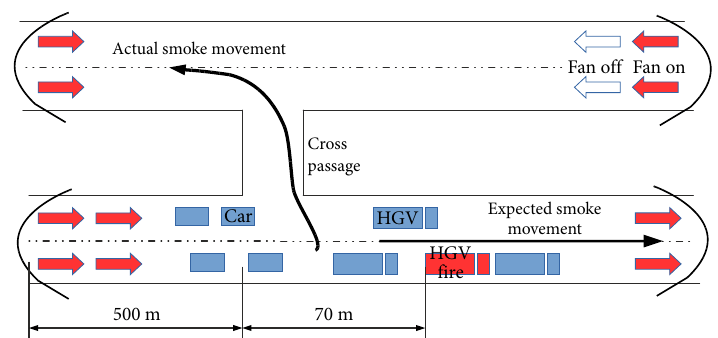
Figure 16. Vehicle and positions and fan operation during the incident